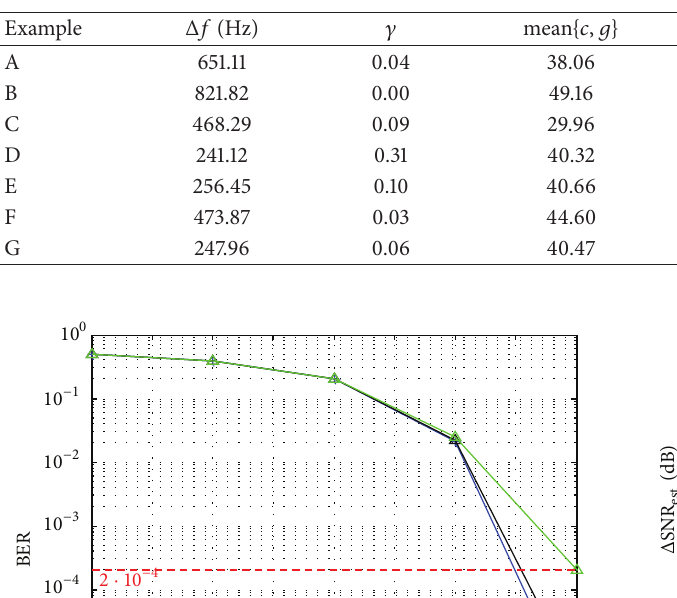
Table 1: Parameters of the representative Doppler spectra.